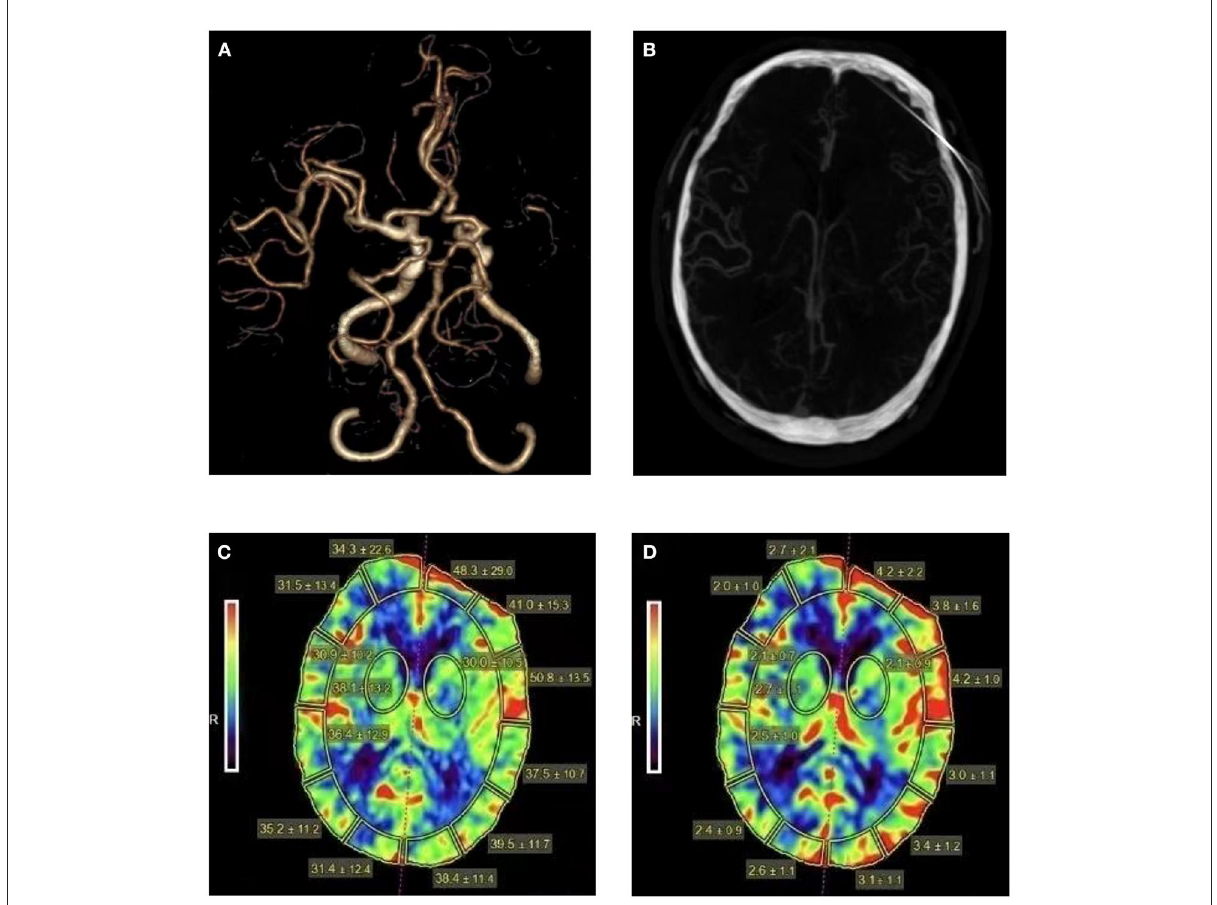
FIGURE1 Head CTA, CTA images reconstructed in arterial phase, cerebral blood flow and cerebral blood volume maps for a patient with middle cerebral artery occlusion. A 64-year-old man presented with right limb weakness and was found to have a left MCA stroke with a 90 days mRS of 2 (A) . Sufficient collateral vessels can be seen in the occluded MCA territory (B) . The CBF (C) and CBV (D) maps show elevated CBF and CBV of the left hemisphere (CBF ratio = 1.18, CBV ratio = 1.45).